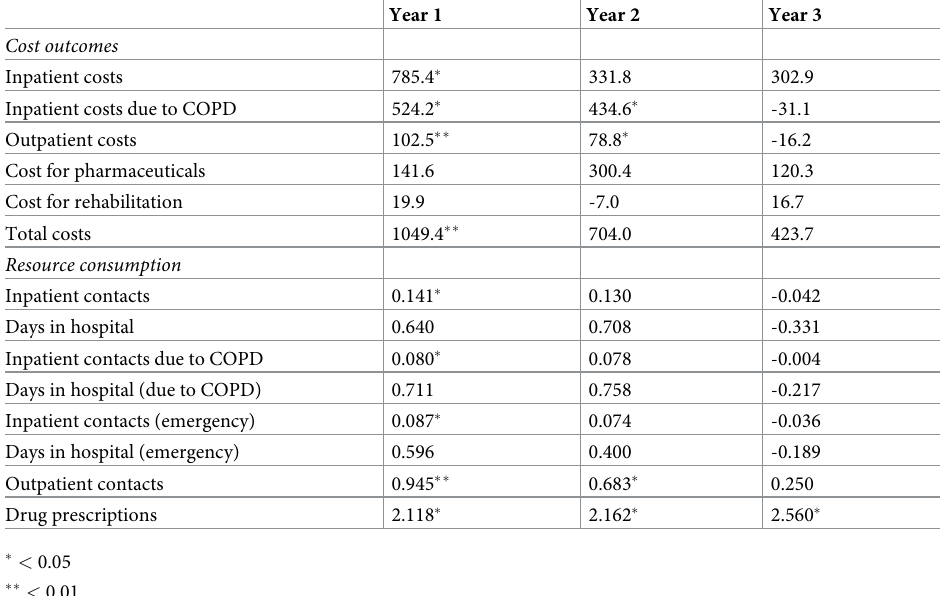
Table 2. Base case regression results. Telemonitoring compared to standard of